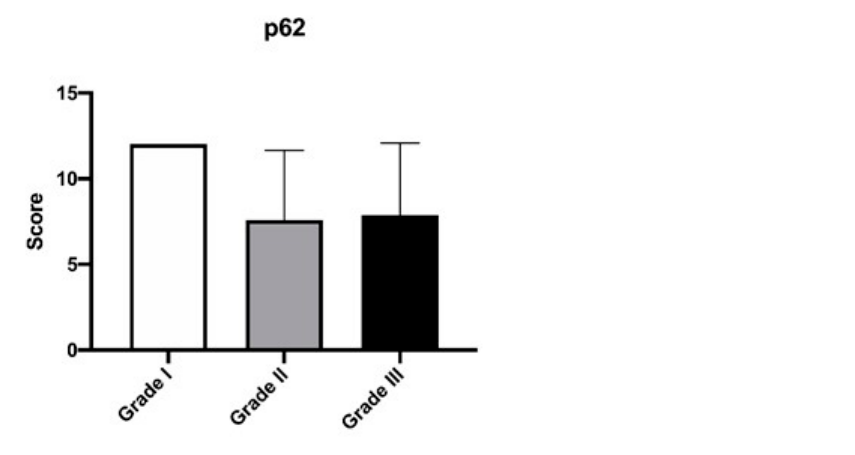
Figure 3. Mean ( ± SD) of the immunoreactivity score for p62 in the cases of feline mammary carcinoma with different grades of differentiation.